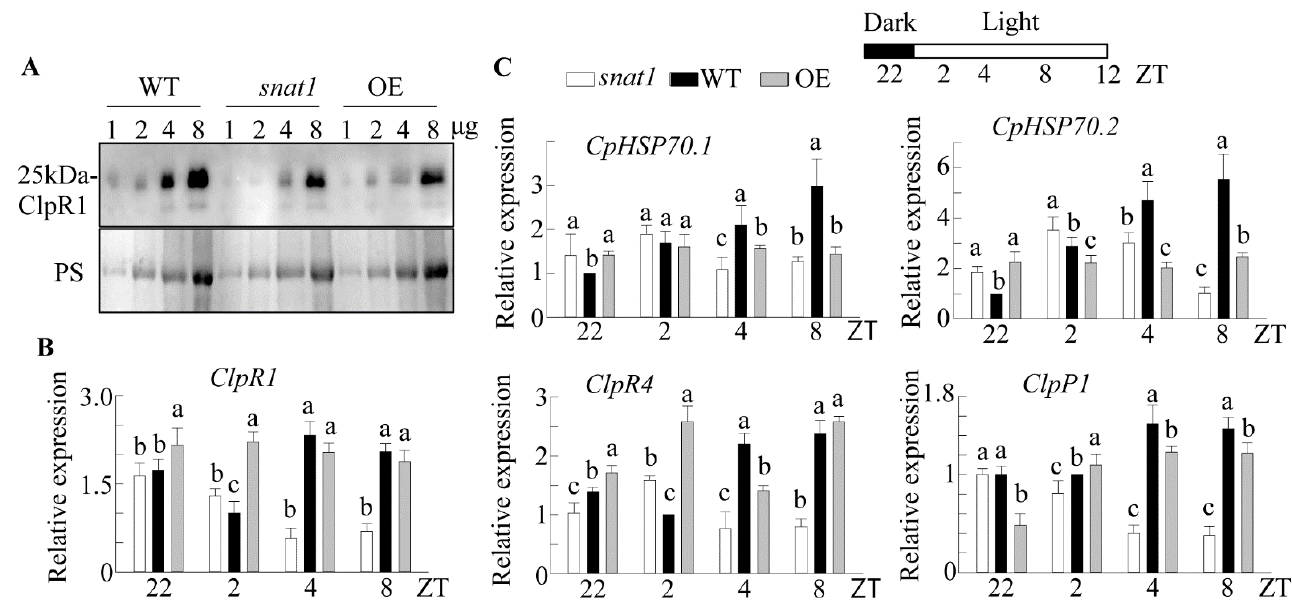
Figure 4 . ( A ) Protein level of ClpR1 in the WT, snat1 , and OE Arabidopsis lines at ZT8. ( B ) Diurnal expression of ClpR1 , ClpR4 , and ClpP1 . ( C ) Diurnal expression of CpHSP70.1 and CpHSP70.2 in the WT, snat1 , and OE lines at various ZT intervals. The relative fold expression values are normalized to EF1 α expression. Error bars show the standard deviation of three biological replicates. The Ponceau S solution (PS) was used as a protein loading control. Different letters indicate significant differences (Tukey’s post hoc HSD test; p < 0.05).